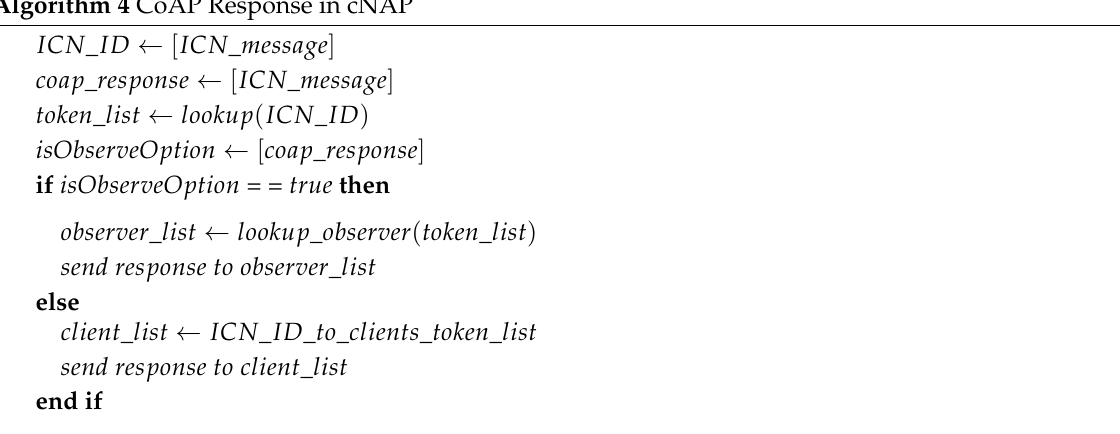
Algorithm 4 CoAP Response in